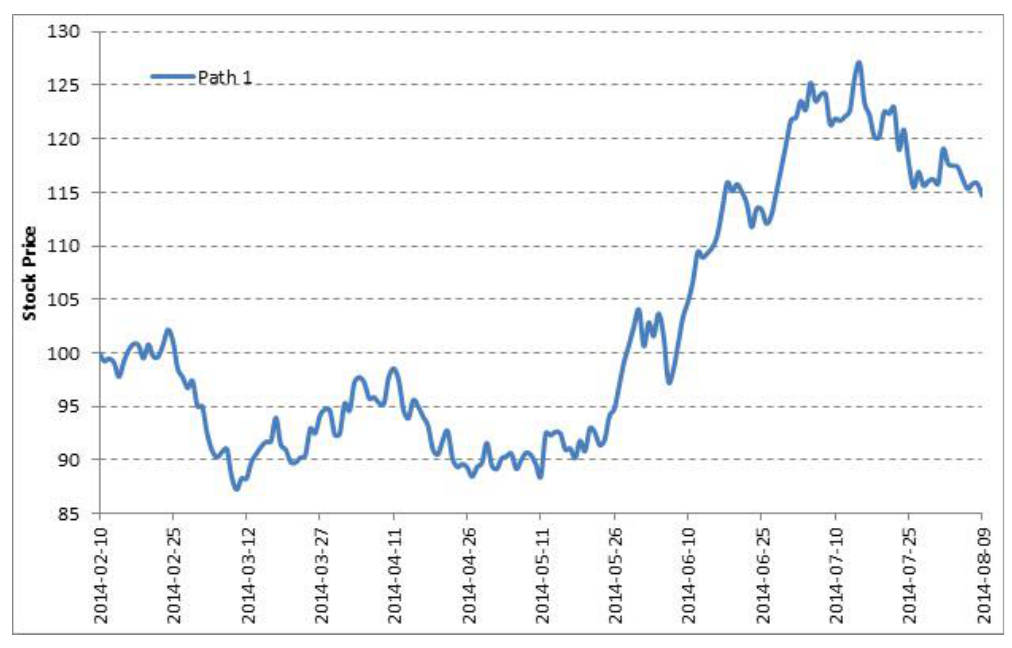
Figure 2. One simulated price path of some stock with a 30% volatility over a six